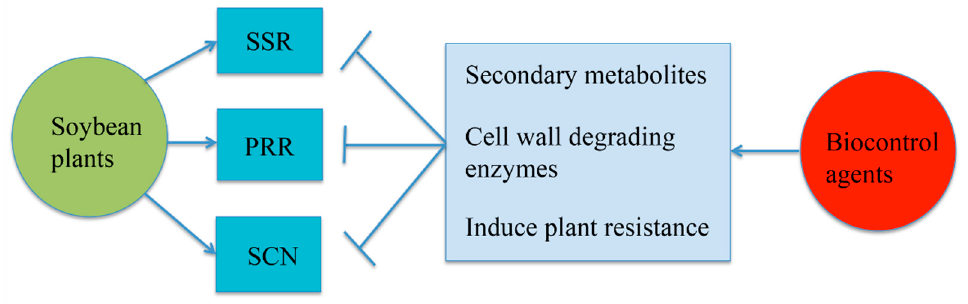
Figure 4. Mechanisms of biocontrol agents to suppress soybean common diseases. SSR: Sclerotinia stem rot; PRR: Phytophthora root rot; SCN: soybean cyst nematode.